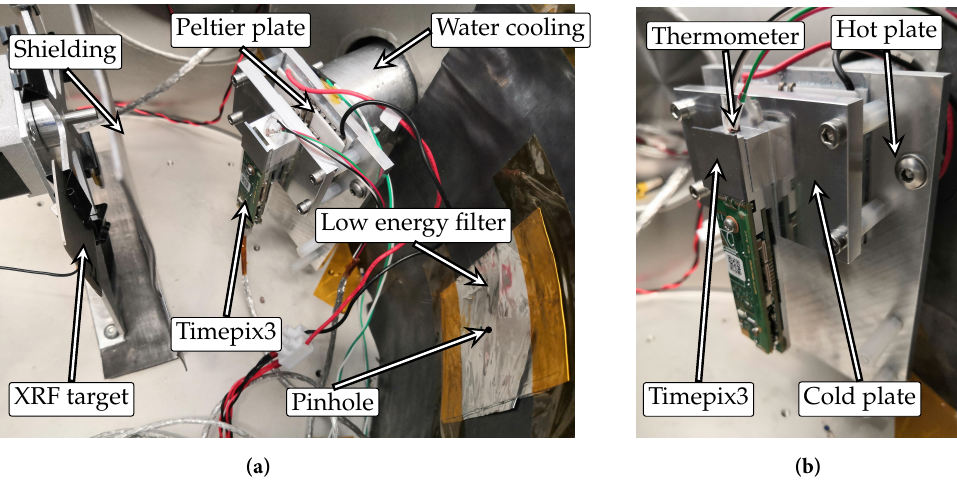
Figure 8. Timepix3 detector arrangement for thermal testing of verification and extrapolation of the compensation model in the vacuum chamber: ( a ) arrangement configuration for X-ray fluorescence measurement; ( b ) details of the detector placement on the Peltier module with feedback thermometer.